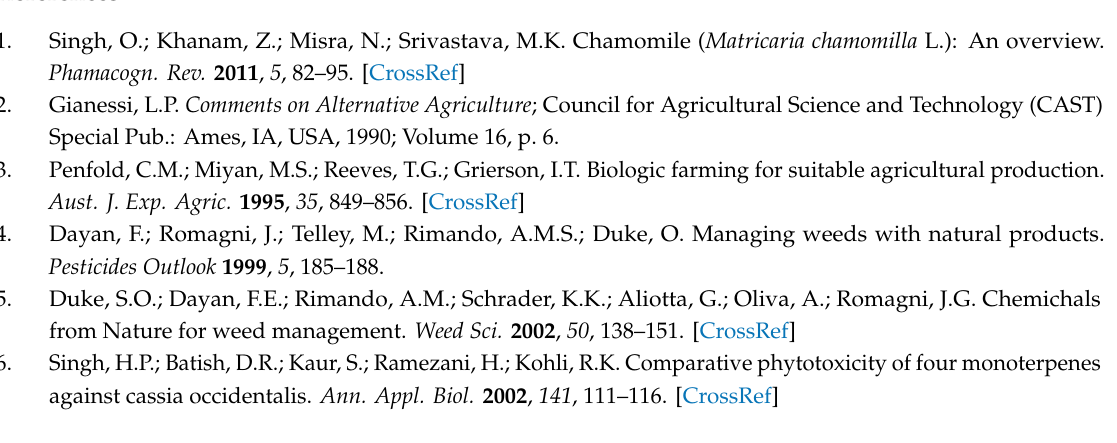
o ffi cinale W. , Avena spp. L., Veronica persica L., showed that the WCE ranged between 29 and 39%. The EOs inhibitory e ff ect on Silybum marianum L., Lactuca virosa L. and Glechoma hederacea L. was less than